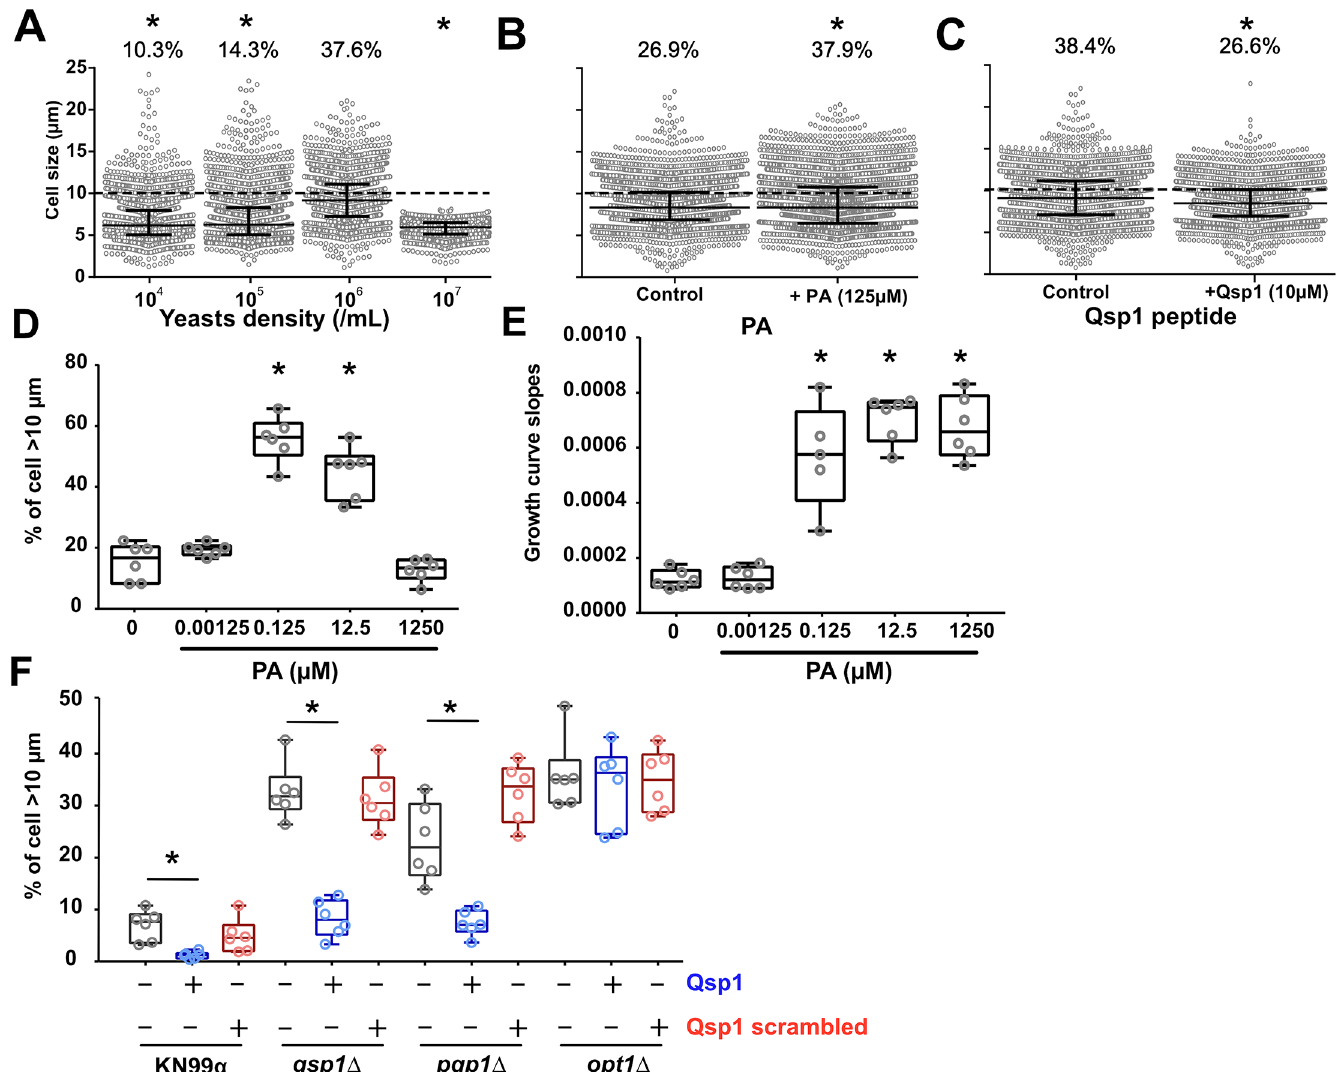
Fig 6. Generation of titan cells in vitro is influenced by cell concentration and quorum sensing molecules. ( A ) The cell concentration at onset of step 2 significantly modified titan cells generation with a maximal titan cells formation using an initial concentration of 10 6 cells/mL, and an abolition of titan cells formation at 10 7 cells/ mL; We then tested several factors at step 3 by adding ( B ) Pantothenic acid (PA) at 125 μ M which had no impact on cell size distribution but significantly increased the proportion of titan cells produced; ( C ) quorum sensing peptide 1 (Qsp1p, 10μM) which significantly decreased cell size distribution and the proportion of titan cells produced; ( D ) The proportion of titan cells generated is influenced by the concentration of PA with a significant increase of titan cells at 0.125 μM and 12.5 μM ( (cid:3) p < 0.001). ( E ) Growth curves were measured continuously during titan cells generation and showed a significant increase of the doubling time (slope) from 0.125 μM of PA. Titan cells formation and growth rate is not correlated since titan cells formation is inhibited at 1250 μM of PA and the doubling time increased. ( F ) Qsp1 acts as a repressor of titan cells formation as the addition of Qsp1 peptide inhibited titan cells formation ( (cid:3) p < 0.001). A control using scrambled peptide showed no effect on titan cells formation. The qsp1 Δ and pqp1 Δ complemented by addition of Qsp1p showed an increase in titan cells formation. No effect of the Qsp1p was observed on opt1 Δ ,the deletion mutant of the Qsp1 transporter Opt1. A specific titan cells inducing conditions was implemented for D, and E to allow induction of titan cells in a 100-well plate and continuous measurements of growth curves using the Bioscreen